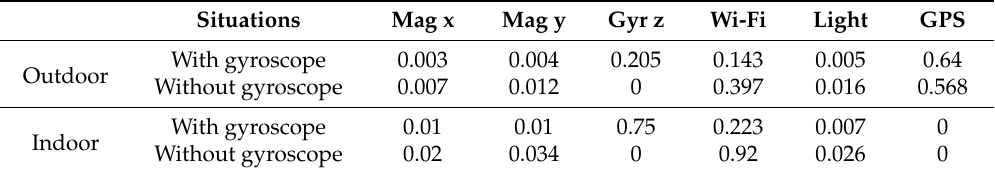
Table 7. Weight of